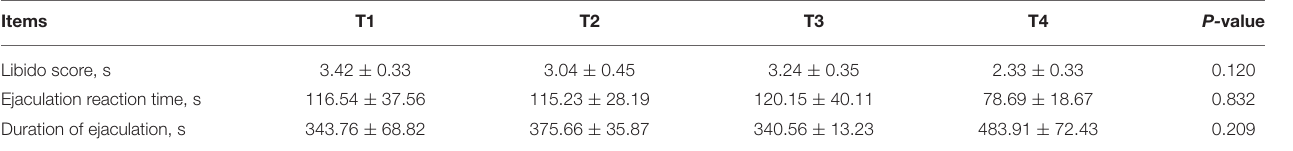
TABLE 3 | Effect of dietary fiber and metabolites on libido of boars.